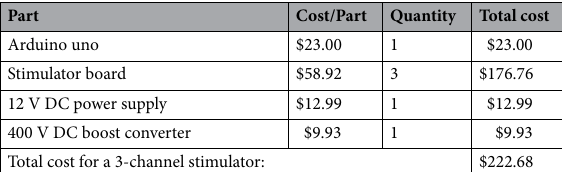
Table 2. High-voltage 3-channel stimulator parts cost.